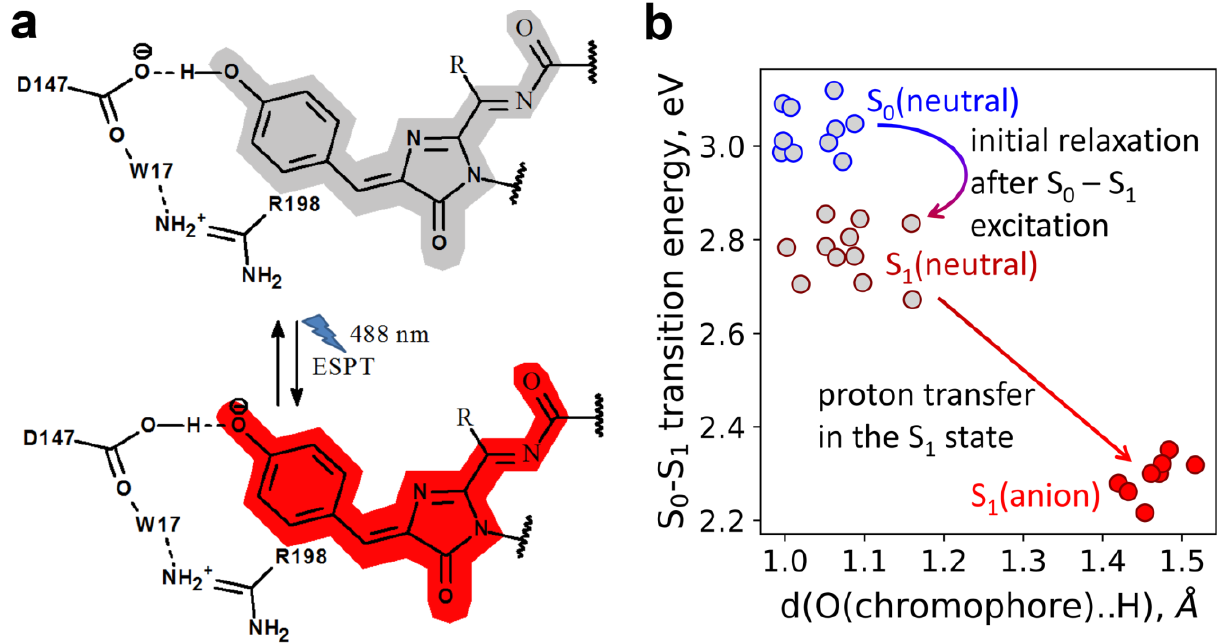
Figure 6. Suggested ESPT mechanism for LSSmScarlet. ( a ) The proton from the phenolic hydroxyl group of the chromophore migrates to the D147 residue after the excitation of the chromophore with 488 nm light. Upon relaxation into ground state from excited state proton comes from D147 residue back to the phenolic hydroxyl group of the chromophore. D147 residue forms water-mediated hydrogen bond with R198 residue (please, see also Figures 5c,d and 7b). ( b ) The ESPT mechanism obtained in the QM/MM MD simulations. Circles correspond to the selected frames from trajectories: grey circles are for the neutral state (with blue and maroon edges for the S 0 and S 1 states, respectively), and red circles are for the anionic S 1 state. The vertical axis depicts the S 0 – S 1 transition energies calculated at the QM(CAM-B3LYP/def2- SVP)/MM(CHARMM) level.